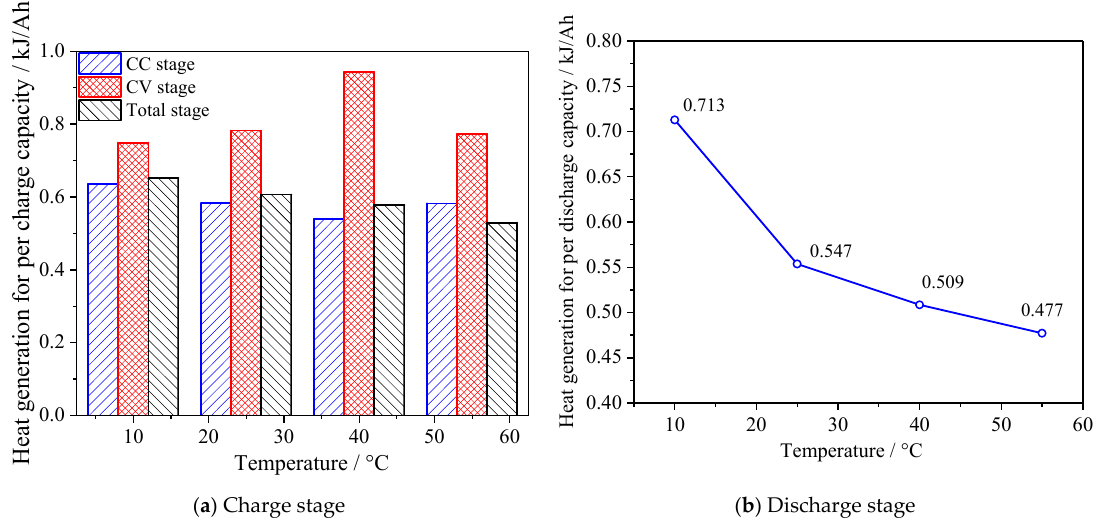
Figure 12. Heat generation for per capacity changing as ambient temperatures increase under the operating current of 2 A.